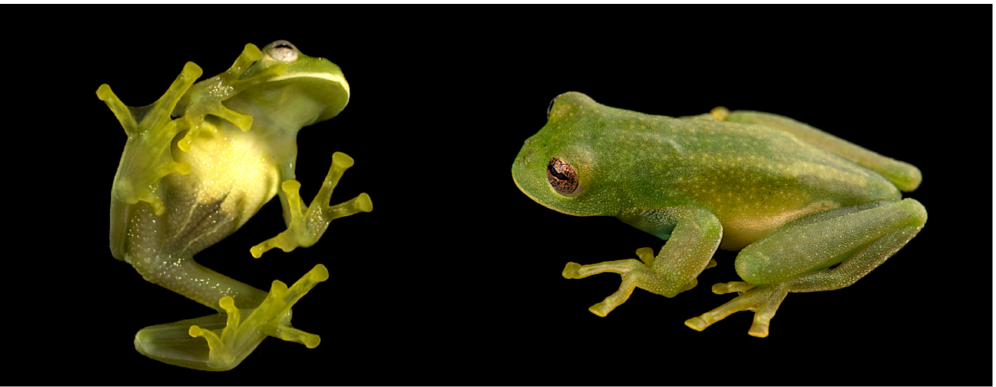
Figure 25. Centrolene buckleyi in life. ( Left ): Adult male from locality near Oyacachi, Napo province, 3012 m, MZUTI 763, photo by Eduardo Toral. ( Right ): Adult male from Guarumales, Zamora Chinchipe province, 2070 m, CJ-11364, photo by Diego Acosta-L ó